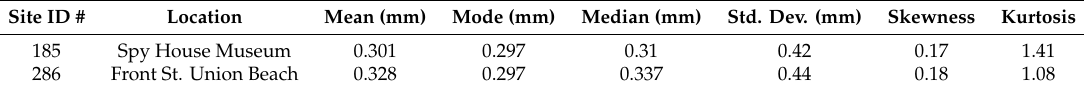
Table 2. Sediment size data in the vicinity of Keansburg Inlet dimensional values in mm